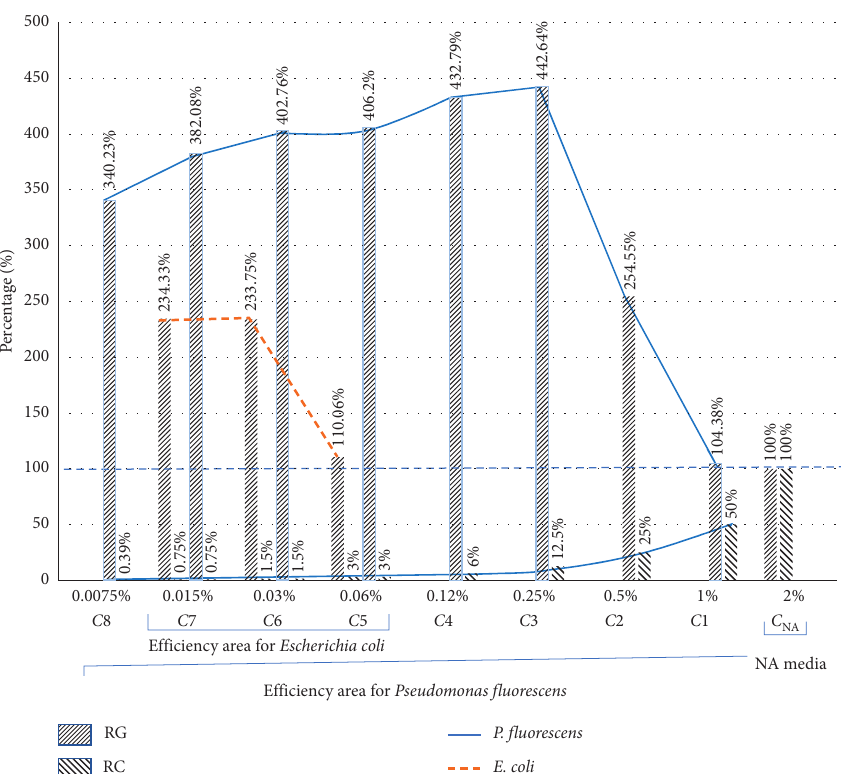
Figure 1: Evolution of the relative growth (RG) of Escherichia coli and Pseudomonas fluorescens and the relative concentration (RC) of cutaneous excreta (CEX) in the areas of efficiencies. The relative growth and concentration are expressed as a percentage (%) relative to those of the conventional NA medium which represent 100%. C NA : concentration of the NA medium at